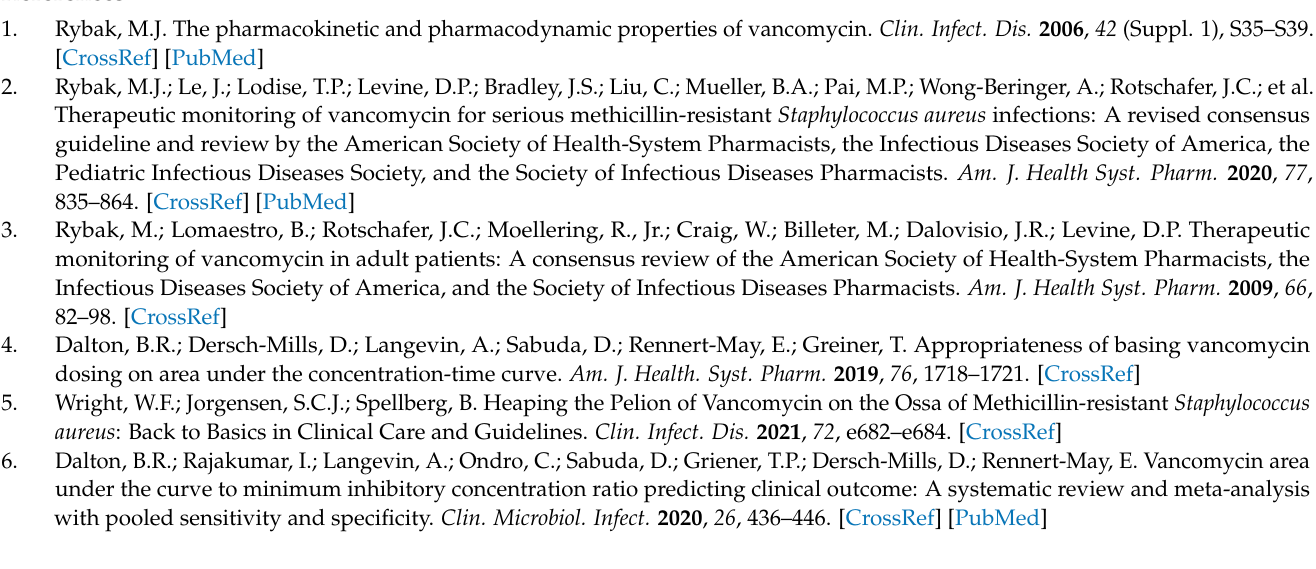
Table S2: Relative bias and relative root mean square error of the five model-based approaches; Supplementary Table S3: Clinically relevant differences between model-predicted and prescribed vancomycin doses; Supplementary Figure S1: Boxplots of the difference between vancomycin doses predicted by the MSA OFV approach and prescribed vancomycin